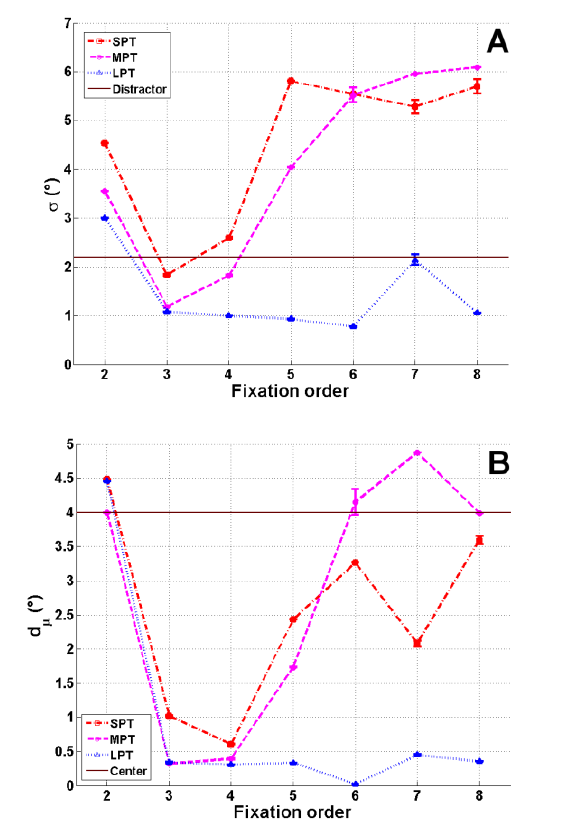
Figure 7: Evolution of 𝜎(𝑡) ( A ) and 𝑑 𝜇 (𝑡) ( B ), in degrees, for the three distractor conditions SPT, MPT and LPT as a function of fixation order. Mean estimations across initialization and